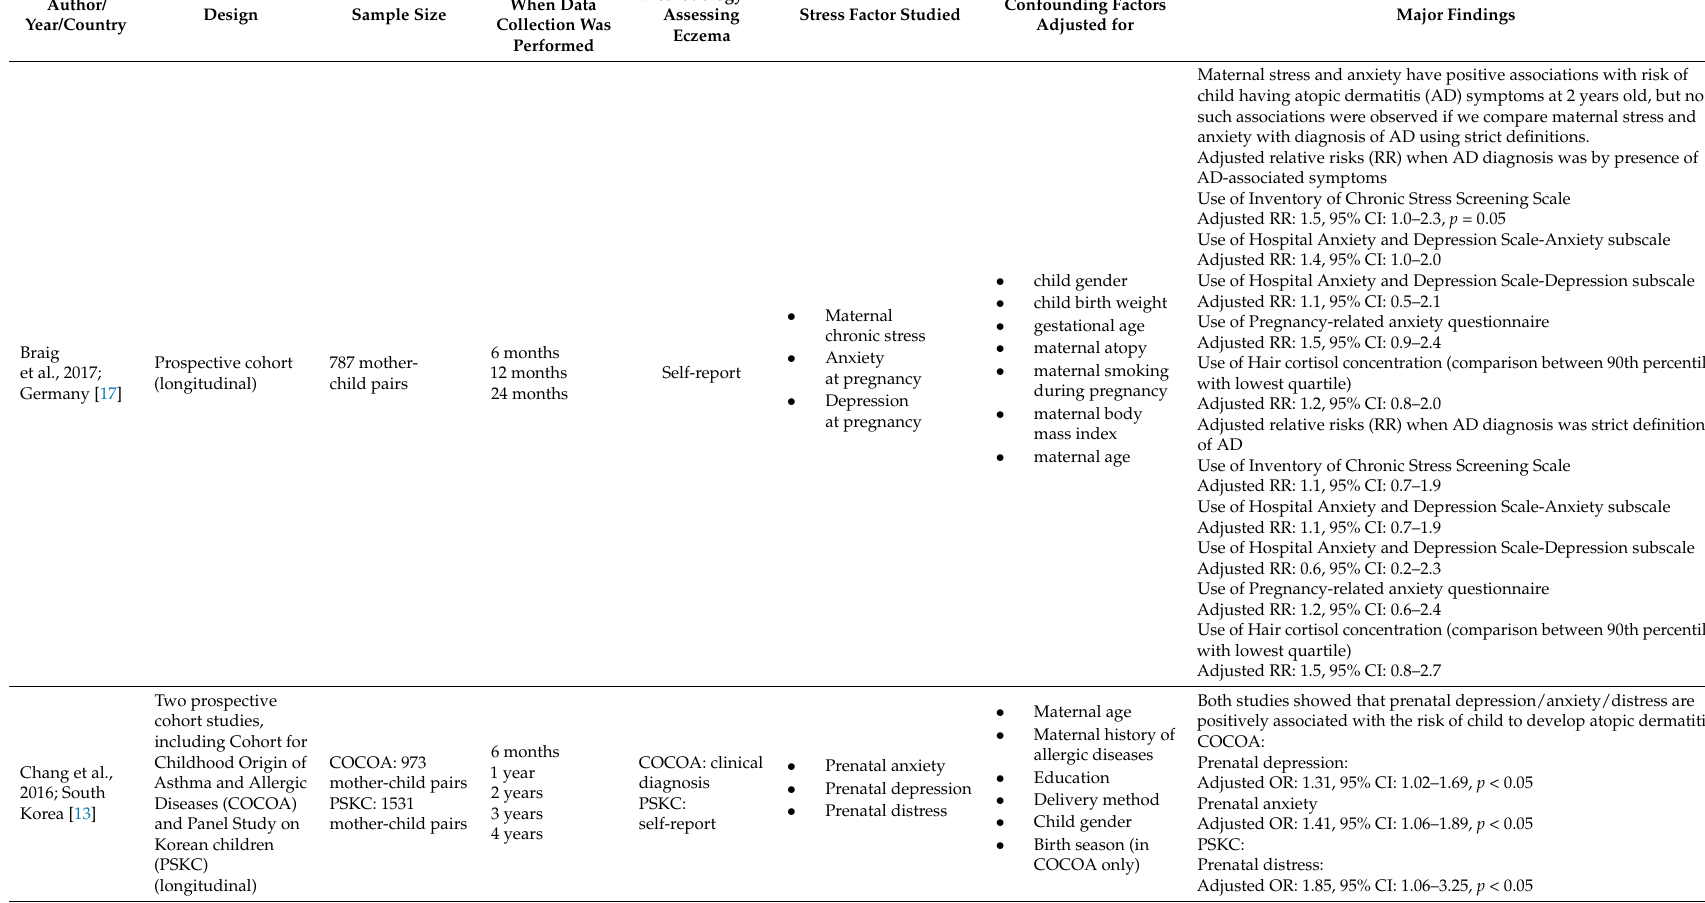
Table 2. The characteristics of the included studies.